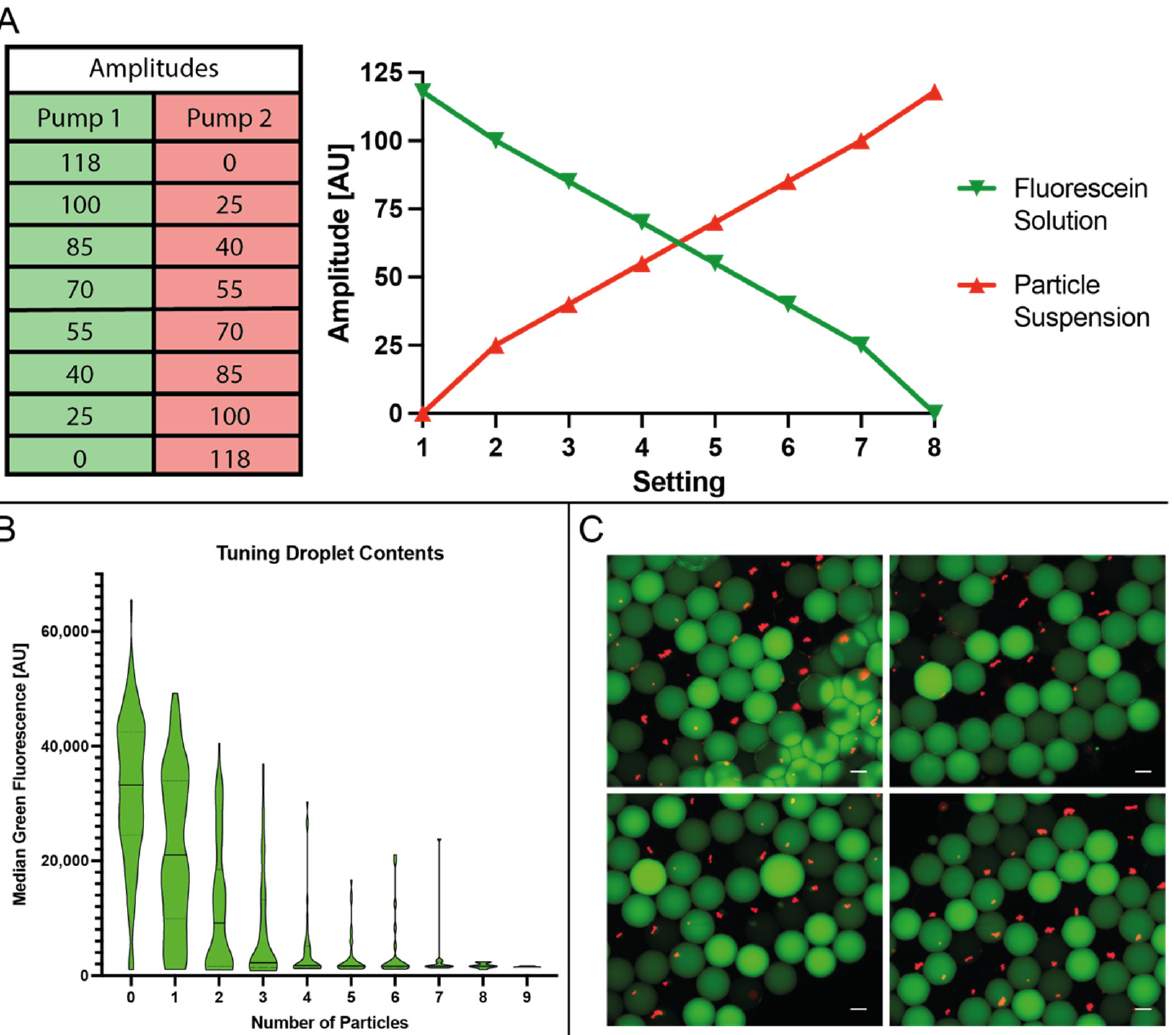
Figure 7. Composition tuning using two pumps at the aqueous inlets. ( A ) illustrates the various settings for dynamic mixing of the two different aqueous samples. ( B ) is a plot of individual droplets’ median green fluorescence over their respective particle content. ( C ) shows four representative images of the emulsion used to obtain the results, combining both fluorescent channels in a composite image. White scale bar represents 100 µm.